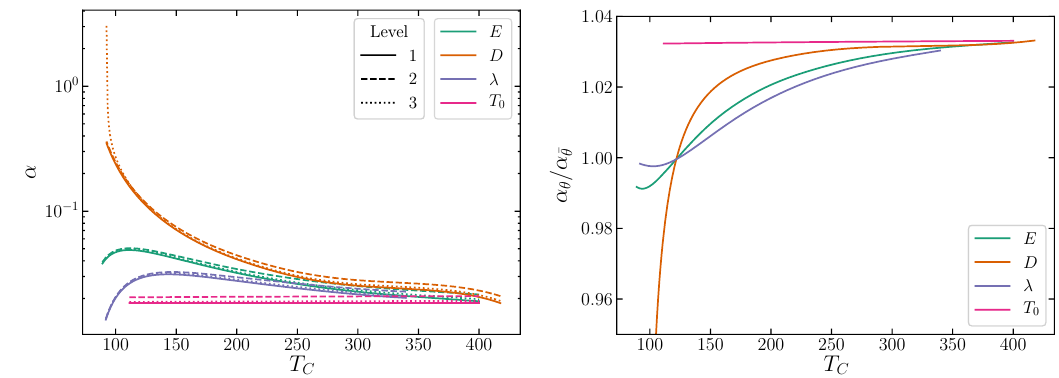
Figure 15 . Left: the strength of phase transition computed at the different levels of diligence. Right: the ratio of strength of the phase transition computed at T beyond the bag model α